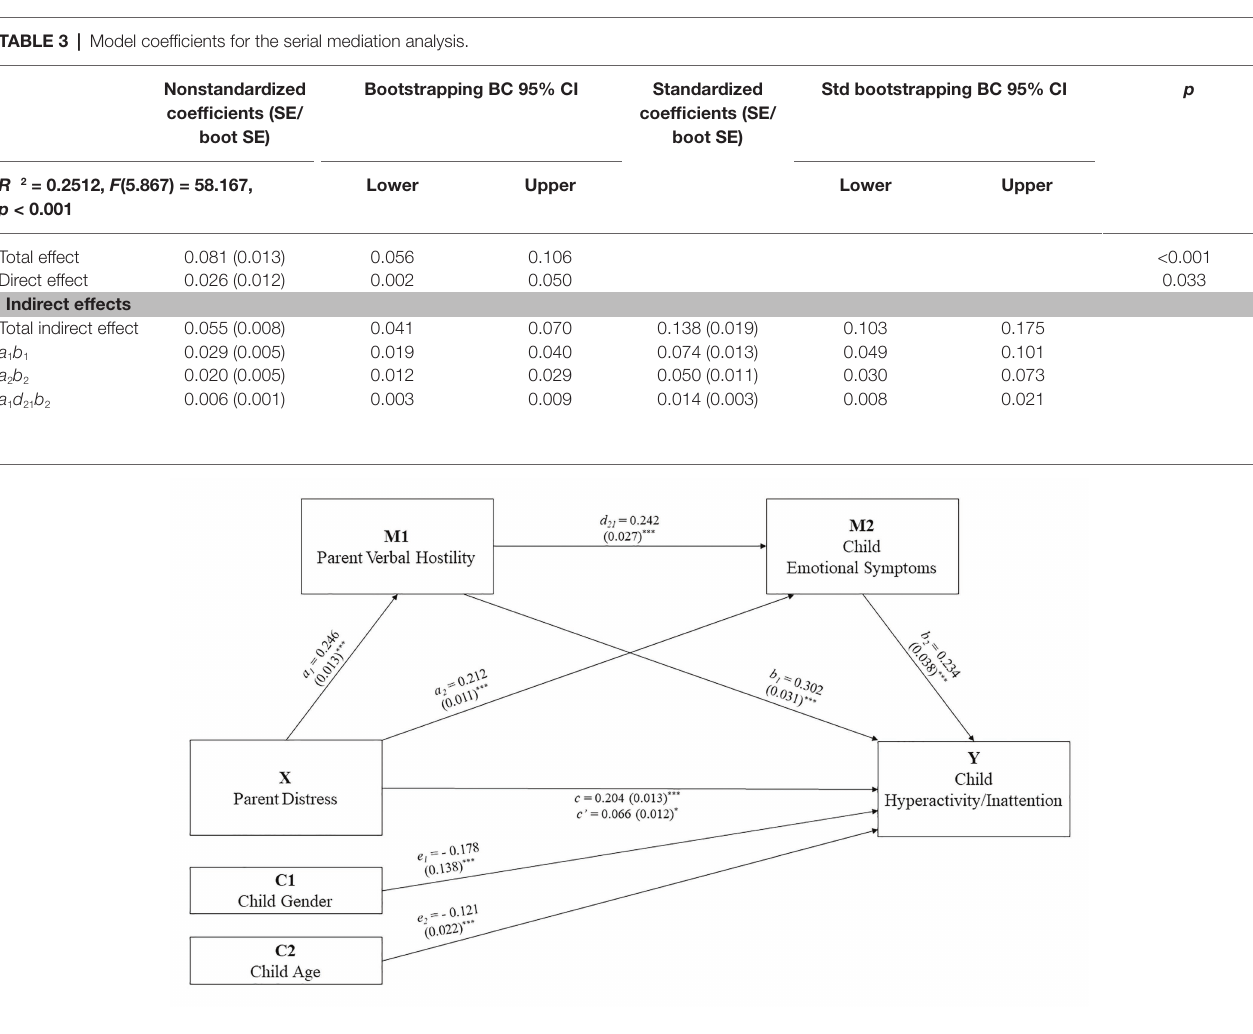
FIGURE 1 | Serial multiple mediation model. Numbers represent standardized coefficients. Numbers within parentheses are standardized errors. * p < 0.05, *** p <